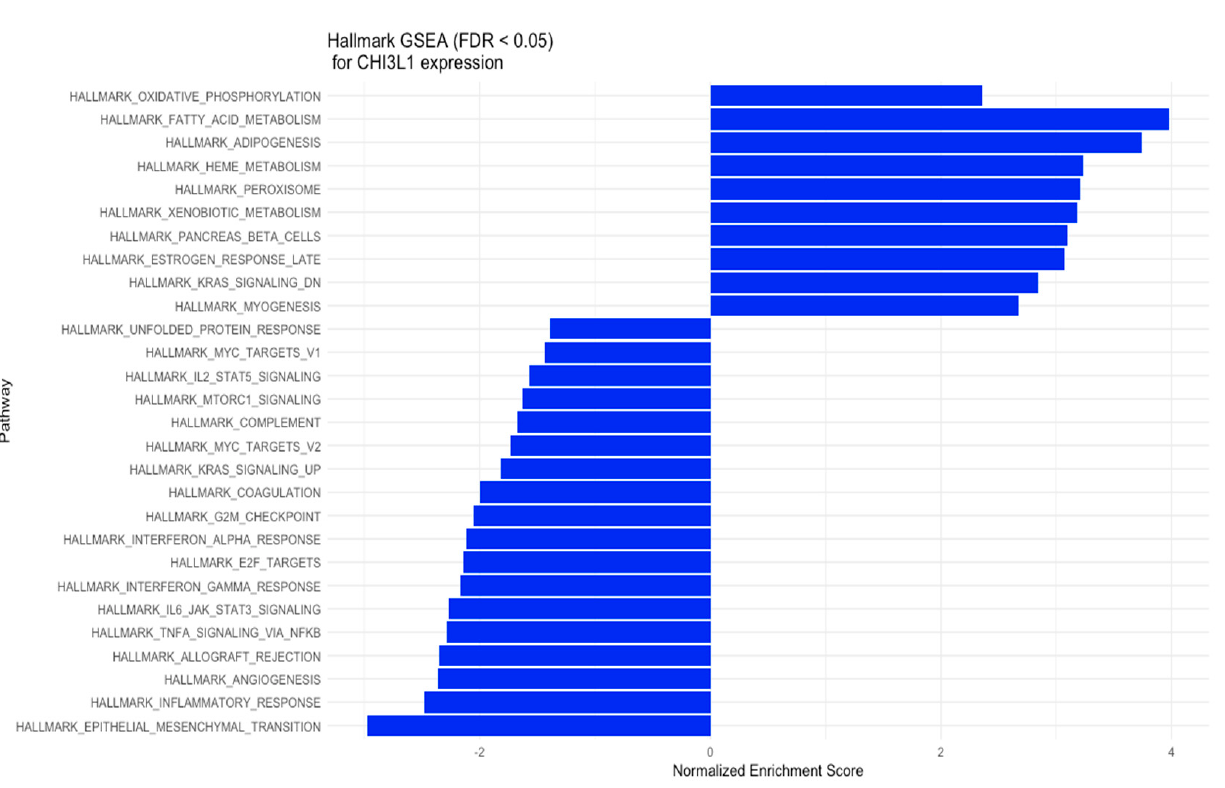
3.2. GSEA Results: Predicted Pathways and Biological Processes for High–Low YKL-40 Expression